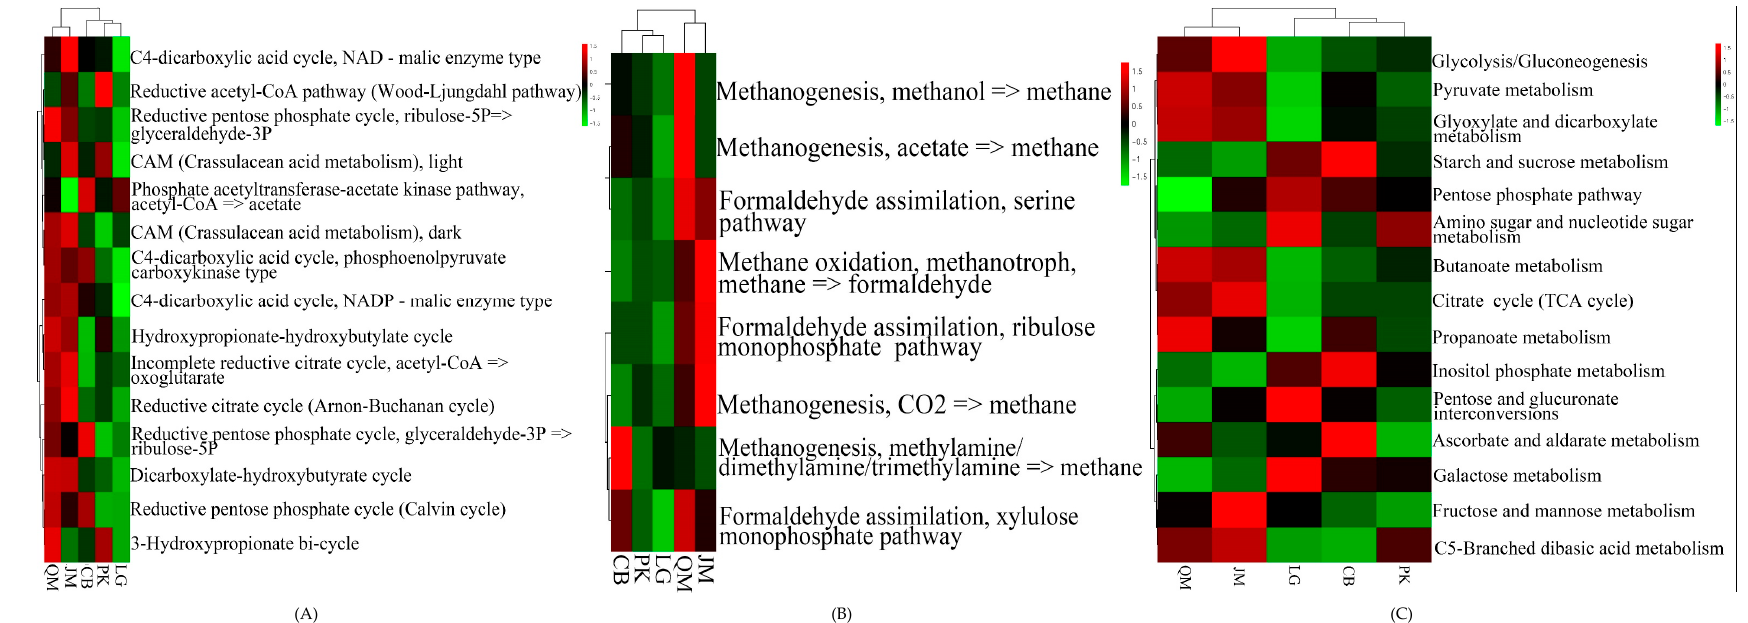
Figure 7. Heatmaps of the C cycles pathways based on KEGG database for different revegetation types. A : Carbon fixation; B : Methane metabolism; C : carbohydrate metabolism. LG: Larix gmelinii ; PK: Pinus koraiensis ; CB: Conifer-broadleaf forest; JM: Juglans mandshurica ; QM: Quercus mongolica